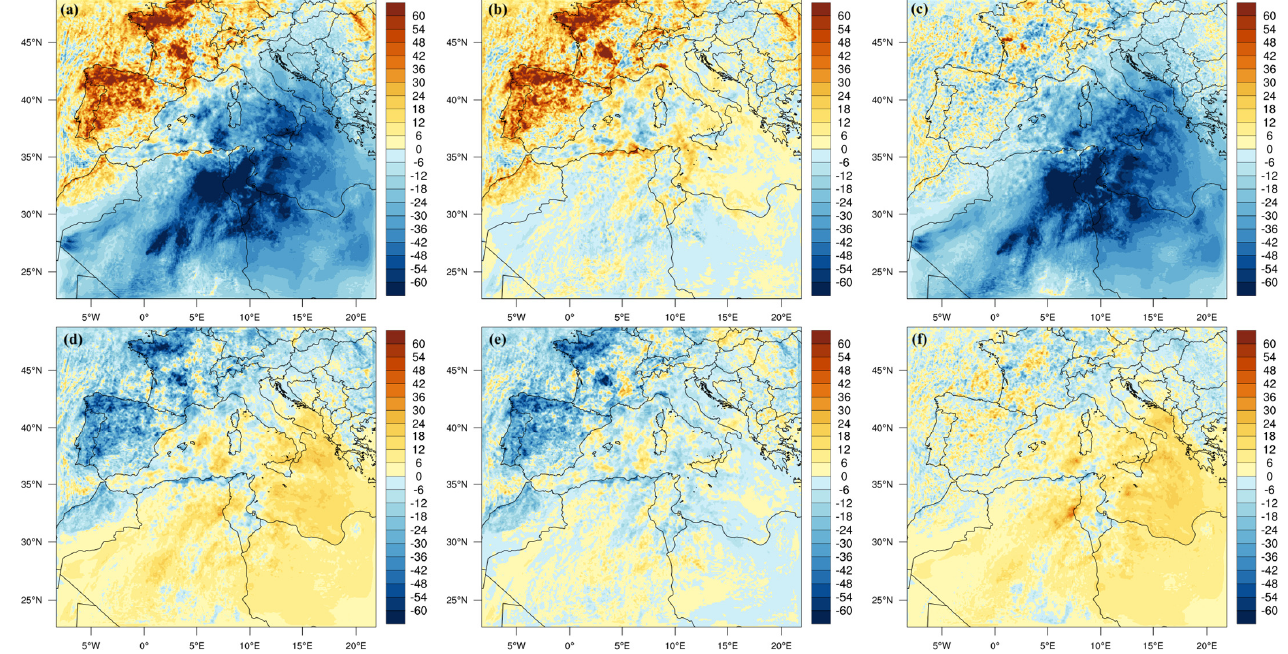
Figure 13. ( a ) Average net dust radiative forcing (DRF) at the surface ( a ) FULL − CTL; ( b ) MP − CTL; ( c ) RAD − CTL. Average net DRF at TOA for ( d ) FULL − CTL; ( e ) MP − CTL; ( f ) RAD − CTL. Units are expressed in W m − 2 .